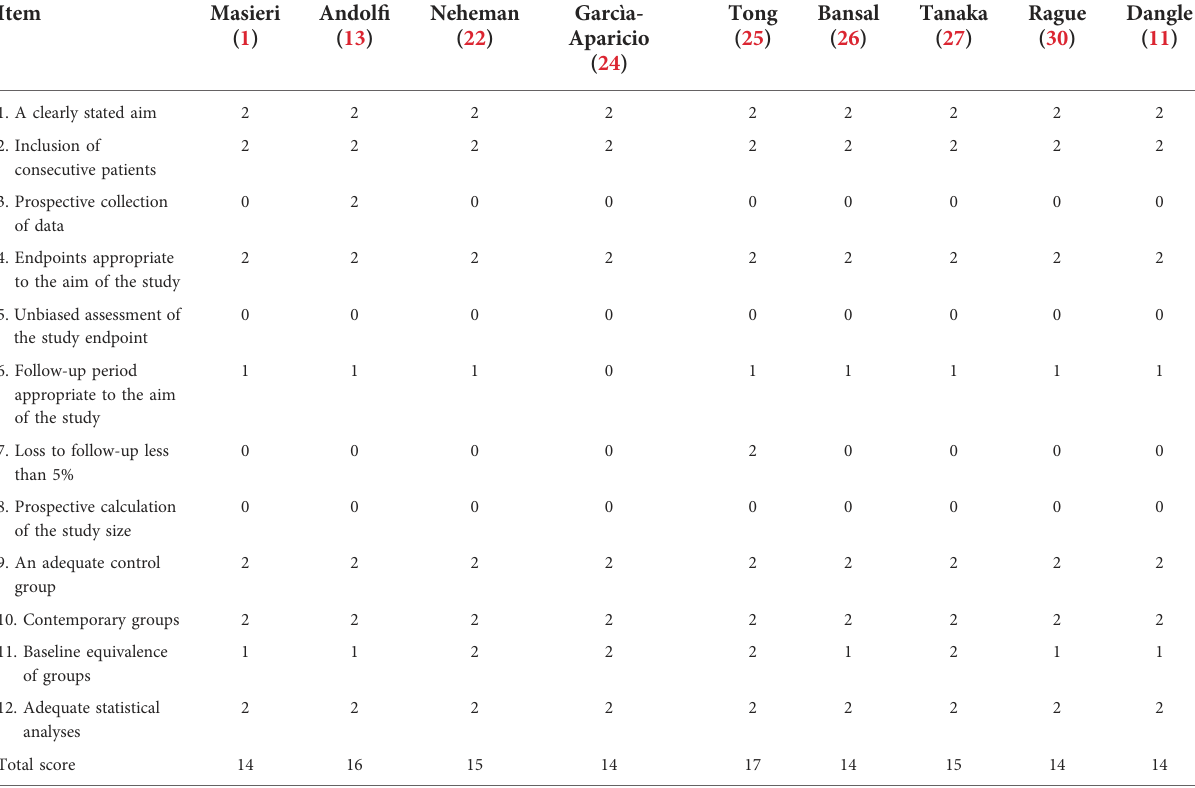
TABLE 3 Risk of bias assessment for individual studies using the methodological index for nonrandomized studies (MINORS) (18).